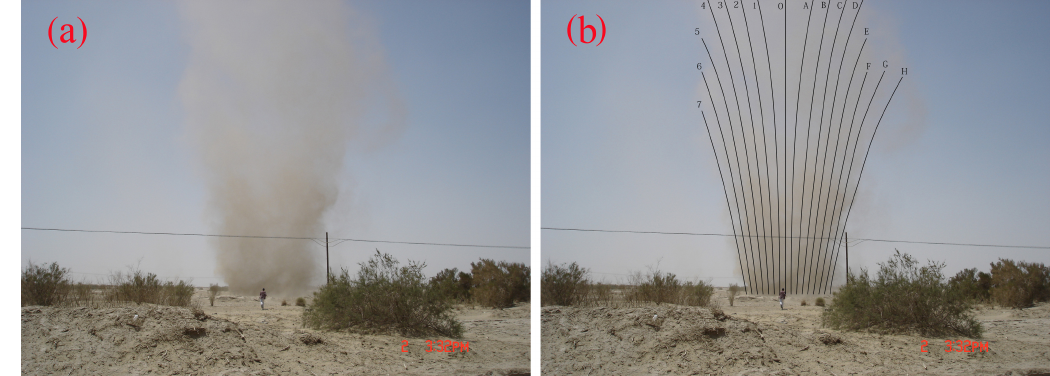
Figure 1. A typical DD observed on 2 July 2014 with (a) the original photo and (b) the image marked with black lines, letters and numbers for the analysis of DD vertical structures. An upright pole near the DD as a reference for measuring the DD.